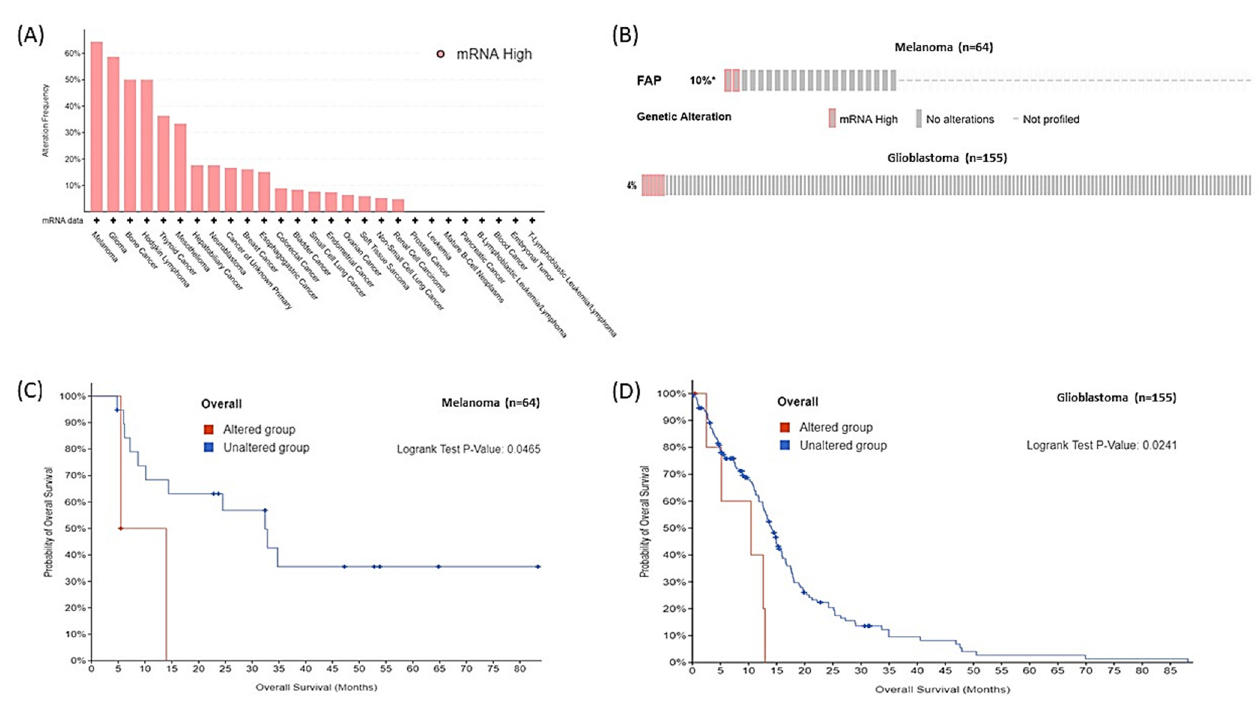
Figure 5. ( A ) Frequency of high FAP mRNA in various human cell lines from CCLE. ( B ) Oncoplots of FAP mRNA expression in melanoma and glioblastoma patient cohorts. Kaplan Meier curves of OS according to FAP mRNA expression (high vs. unaltered) in melanoma ( C ) and glioblastoma ( D ) cohorts. *: % of profiled